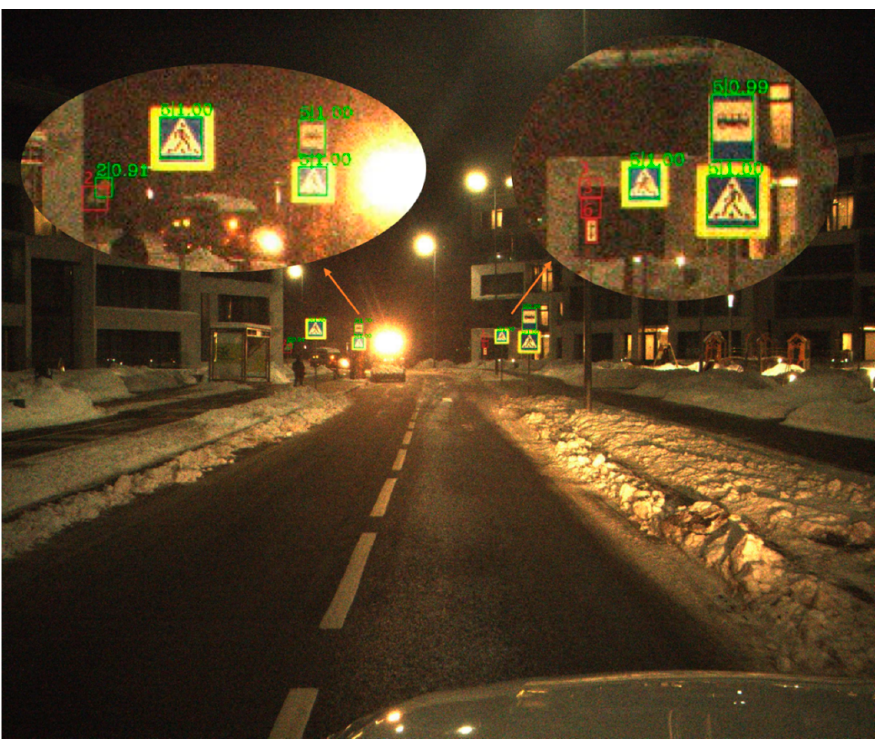
Figure 8. The visualization of the HRNet result on ITSDB detection. Green square represents detection result of the model, and red square represents target missed or detected wrong.